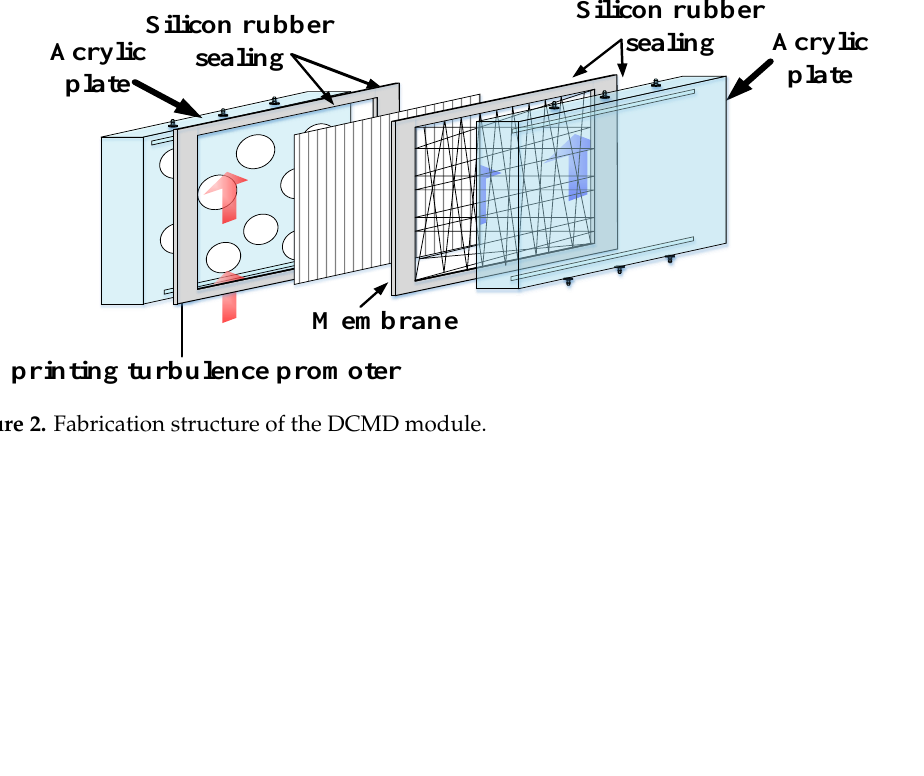
Figure 1. Schematic diagram of the experimental setup for the direct contact membrane distillation (DCMD) system.